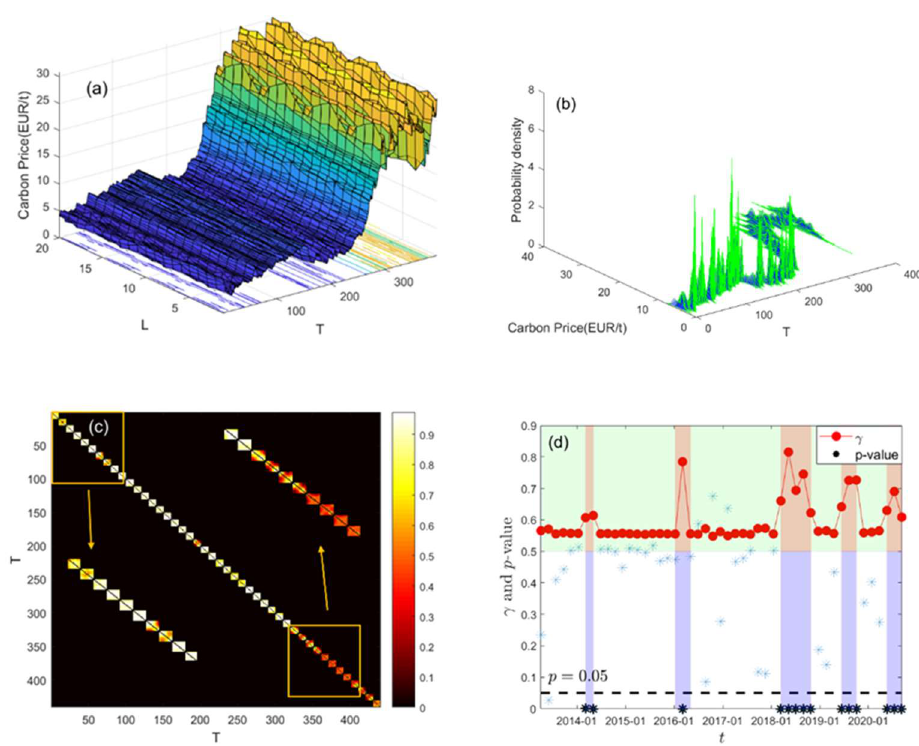
Figure 4. Identification result of breakpoint of daily closing price data of the EU ETS: ( a ) evolution of daily closing price data; ( b ) distribution of probability density; ( c ) evolution of adjacency matrix of PDRN; ( d ) identification of breakpoint.